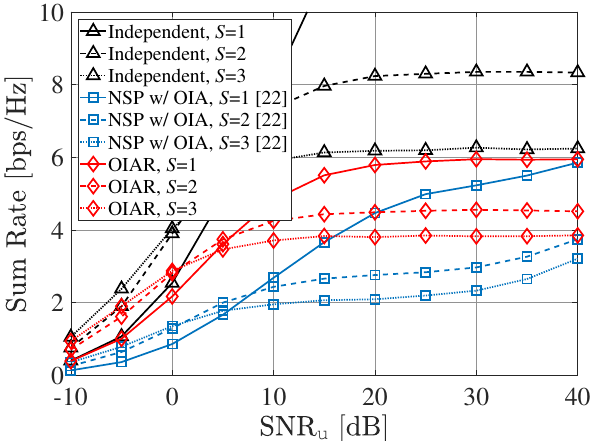
Figure 4. Sum-rate of communication system according to SNR u with different S